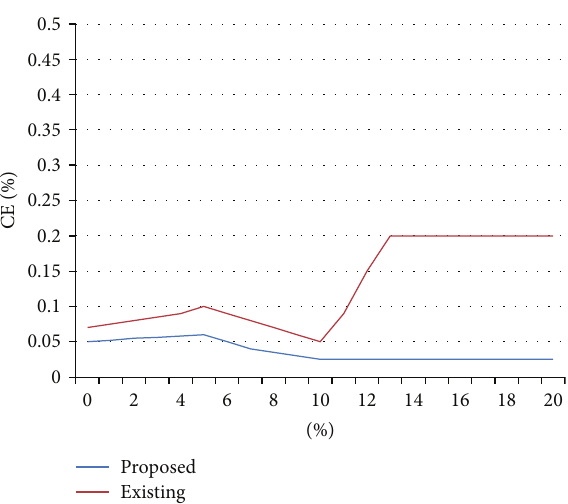
Figure 3: Immunity to outliers for datasets with 𝑙 real = 30 percent of 𝑑